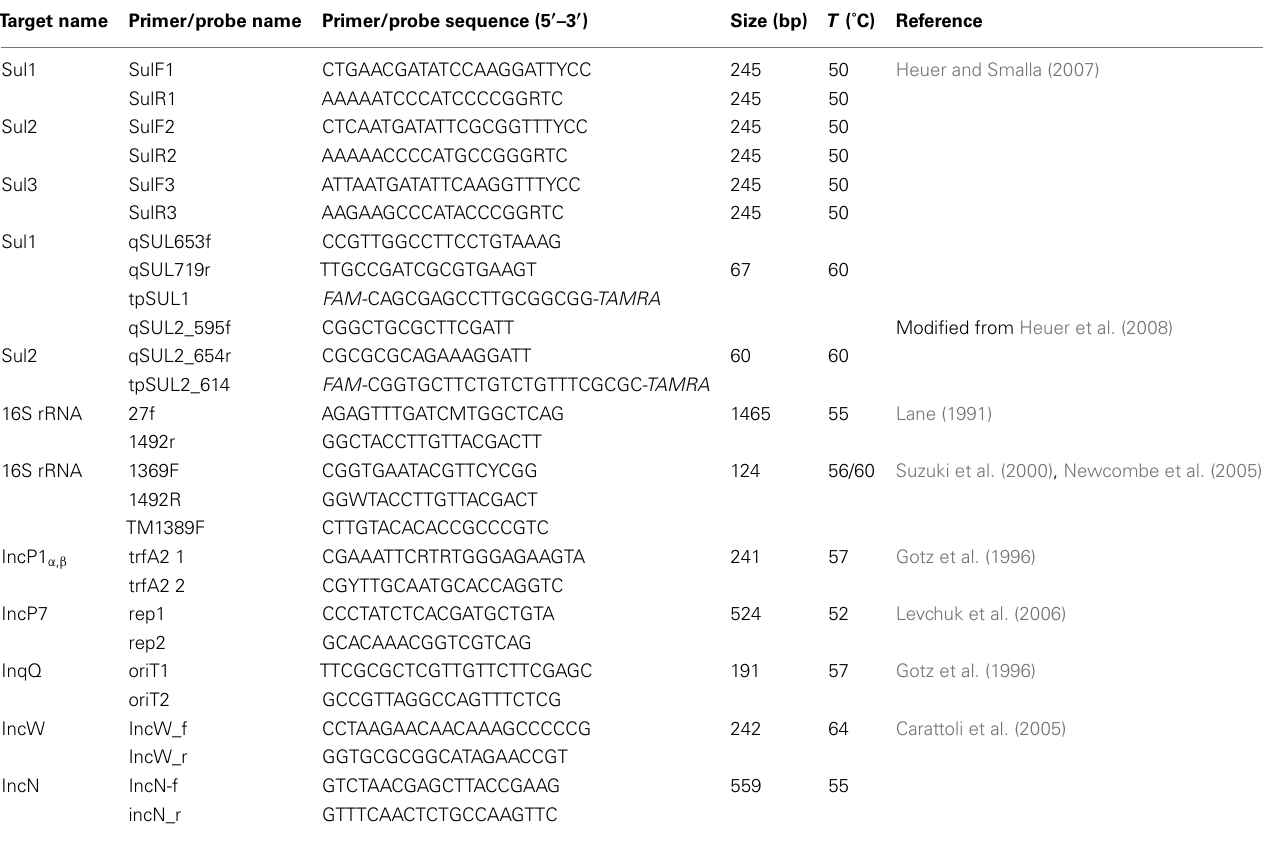
Table 1 | Primers and probes used in the present